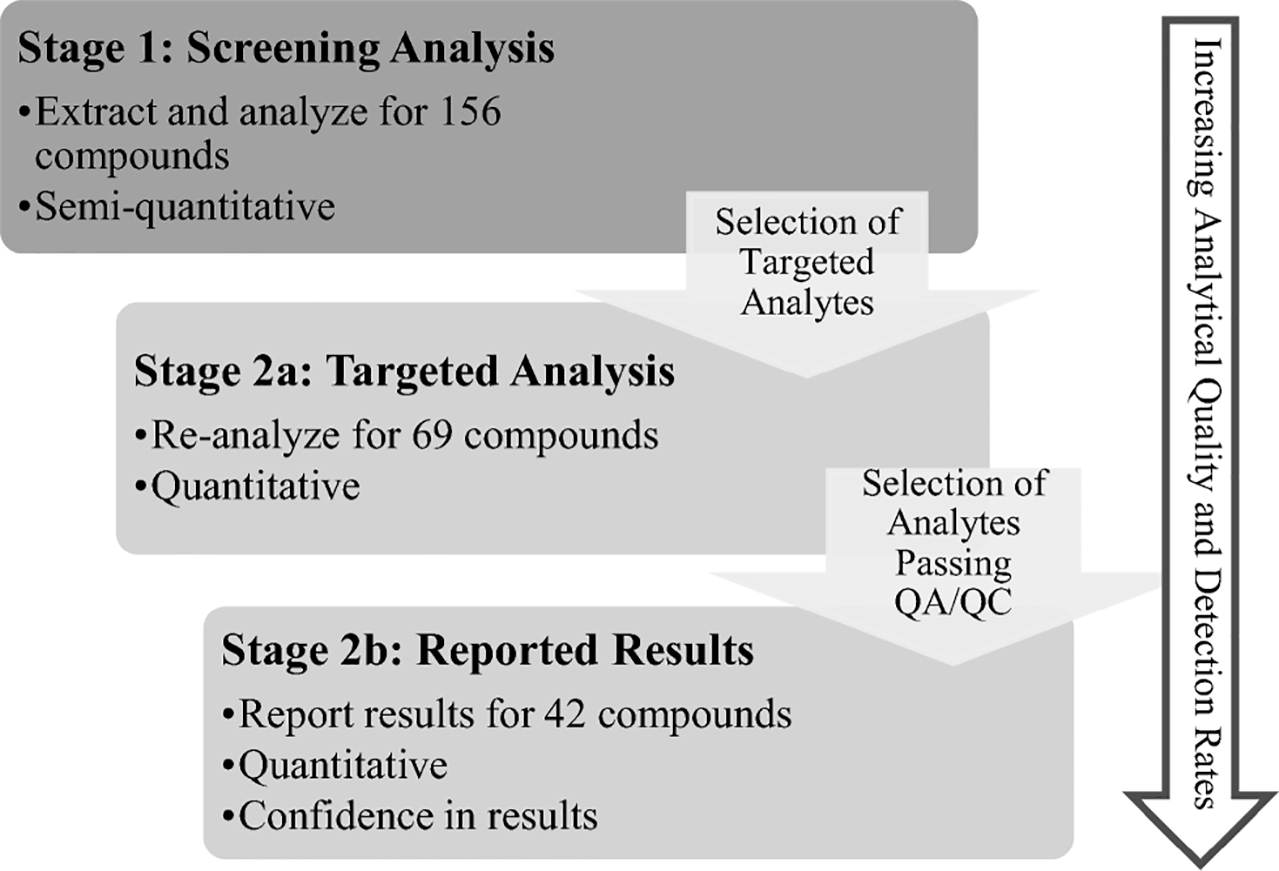
Flow chart of the analytical process from initial screening to reporting results